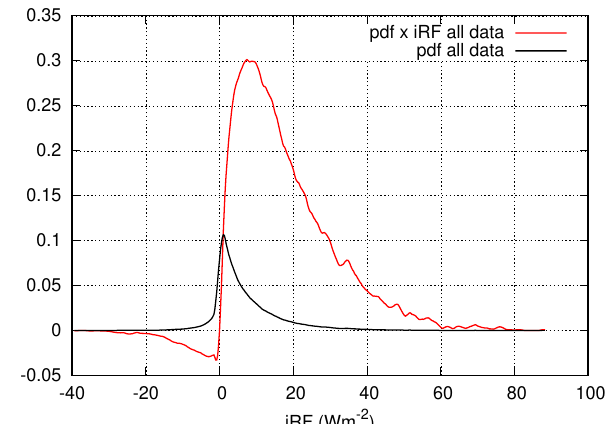
Figure 5. First order effect function for iRF, that is, the product of iRF with its probability vs. iRF. Such a display demonstrates that cases with high iRF, although they have low probability, have quite some importance in the overall RF of